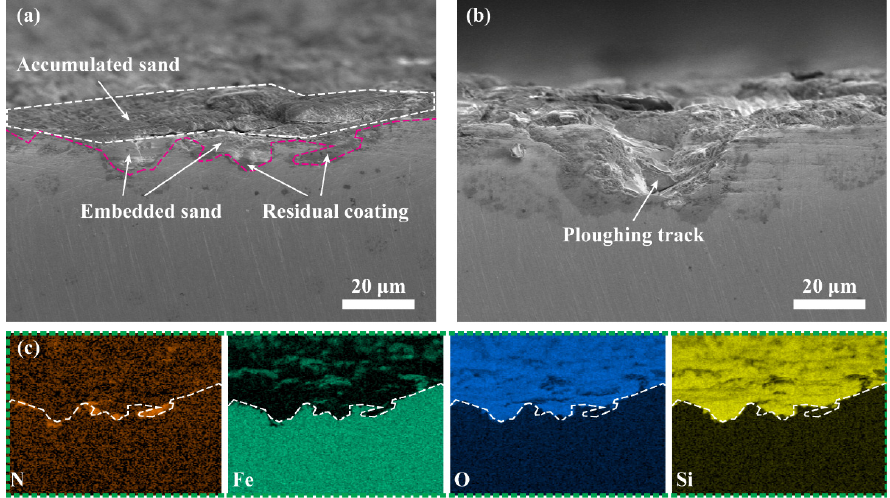
Figure 14. Cross − sectional morphology of nanomultilayer with sand: ( a , b ) Typical feature in mixing zone and sand − affected zone, respectively; ( c ) EDS mapping in ( a ).